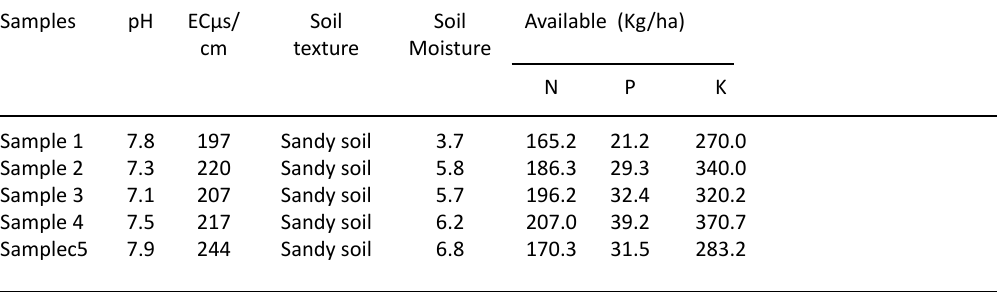
Table 2. Physico - Chemical Properties of soil samples Samples pH ECµs/ Soil Soil